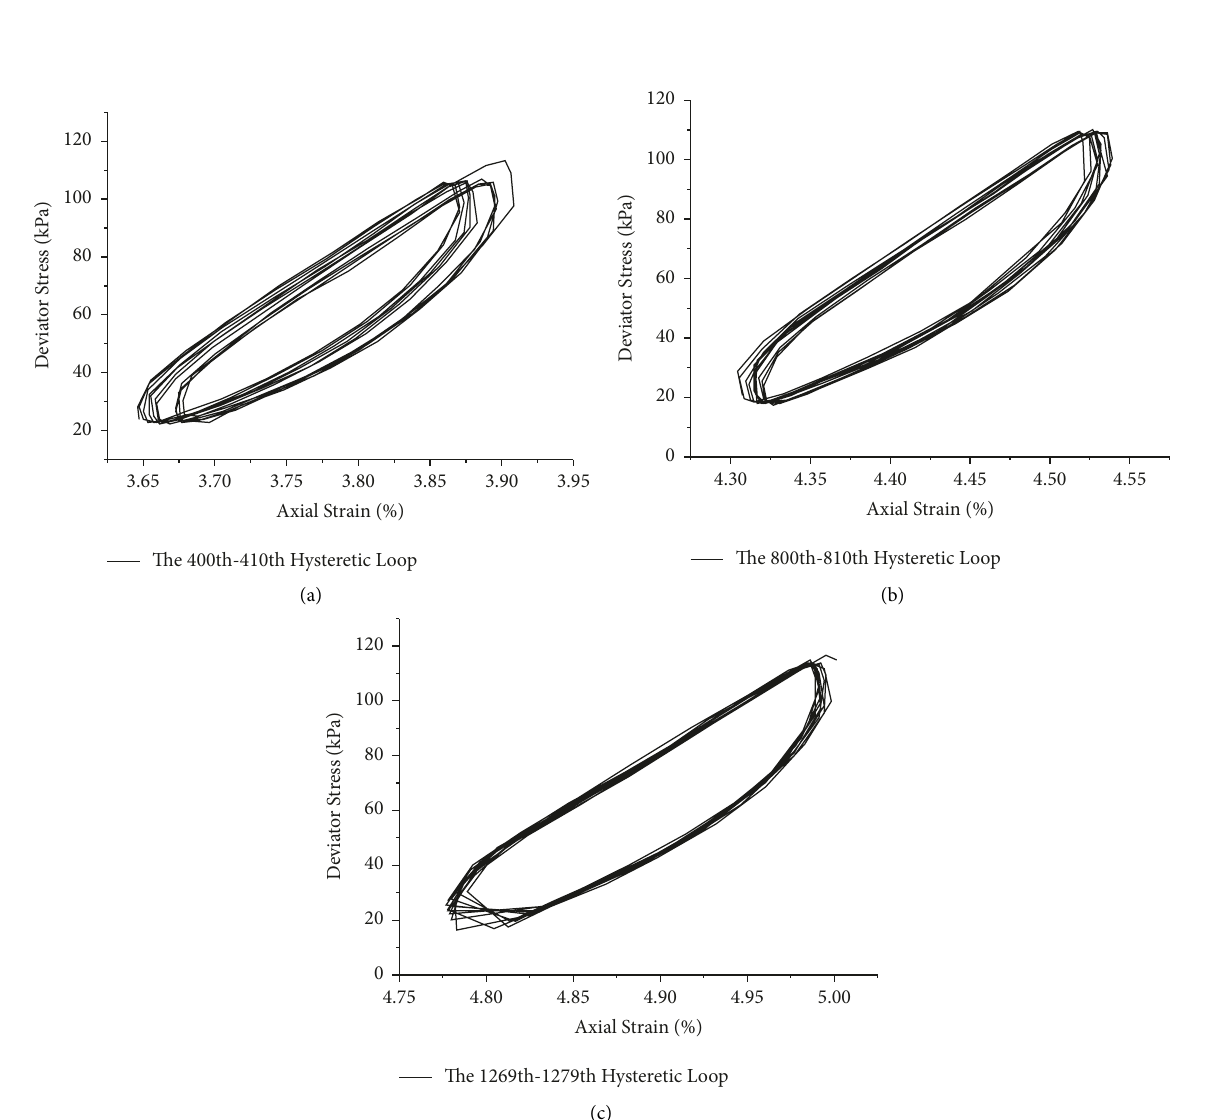
Figure 6: The hysteretic curves while σ hysteretic loop curves. (c) The 1269 th –1279 th hysteretic loop curves.